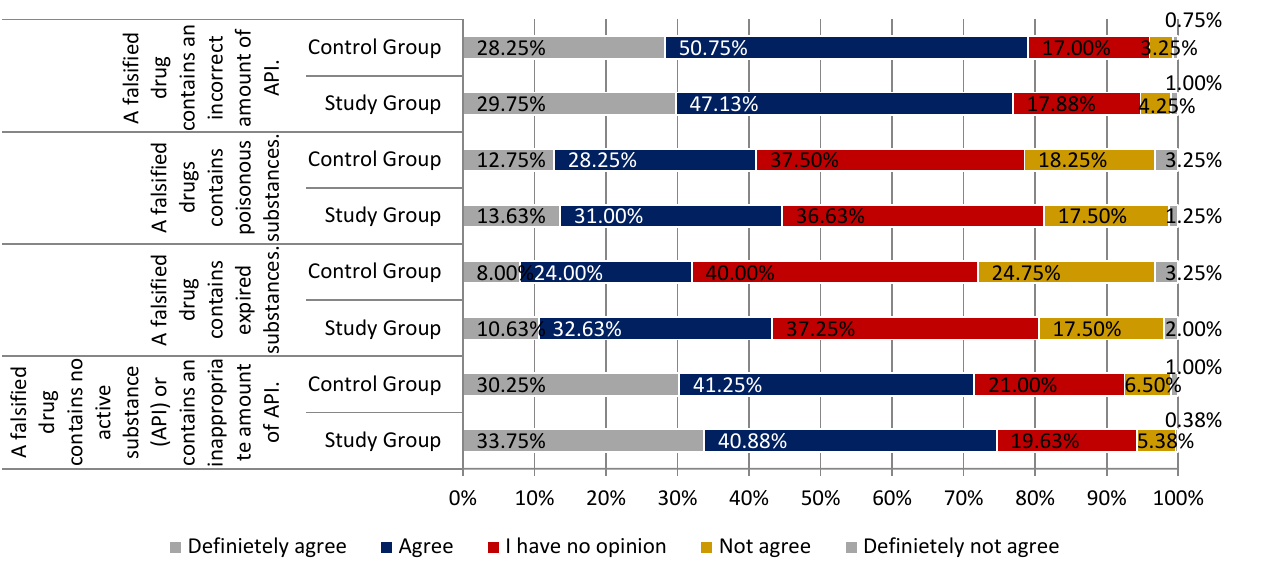
Figure 5. Falsified drugs in the opinion of respondents from the study and control group part 1.